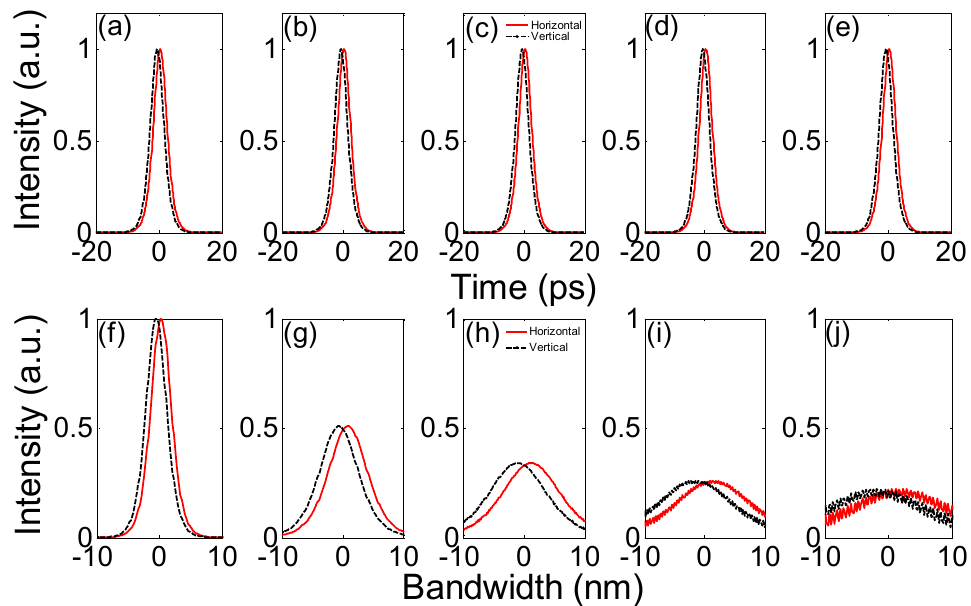
Figure 5. Theoretical results after polarization splitting when the pulse chirp is changed and λ 1 = λ 2 = 1064 nm.